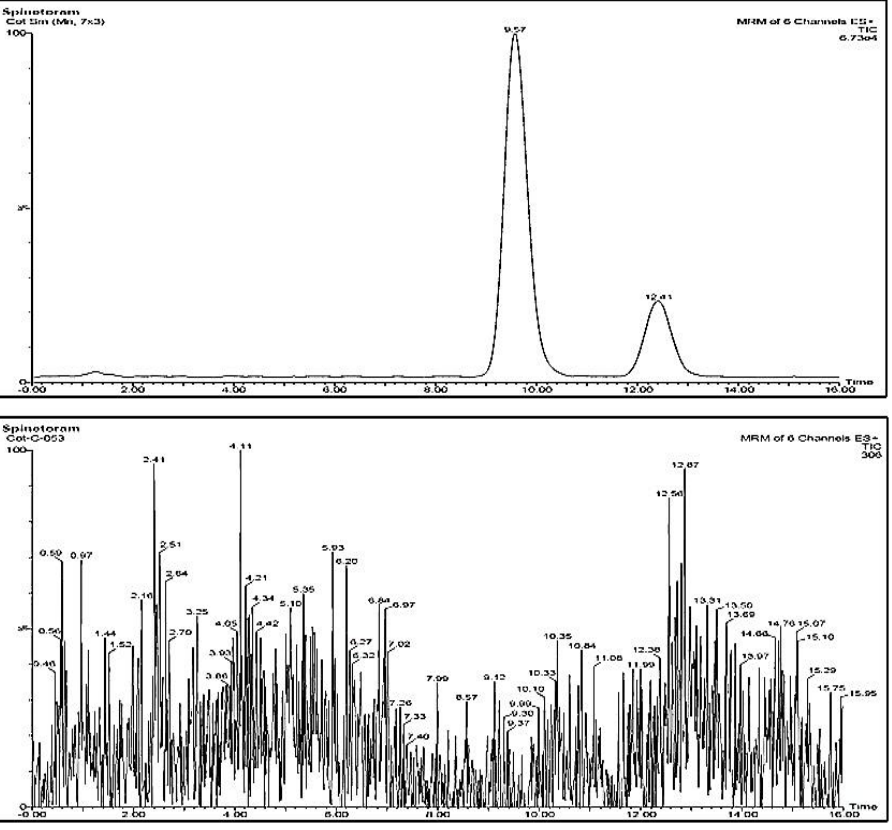
Figure 4. LC ‐ MS/MS chromatogram of spinetoram recovered from cotton when spiked at 25 ng g − 1 ( above ) and chromatogram of control cotton sample ( below ).